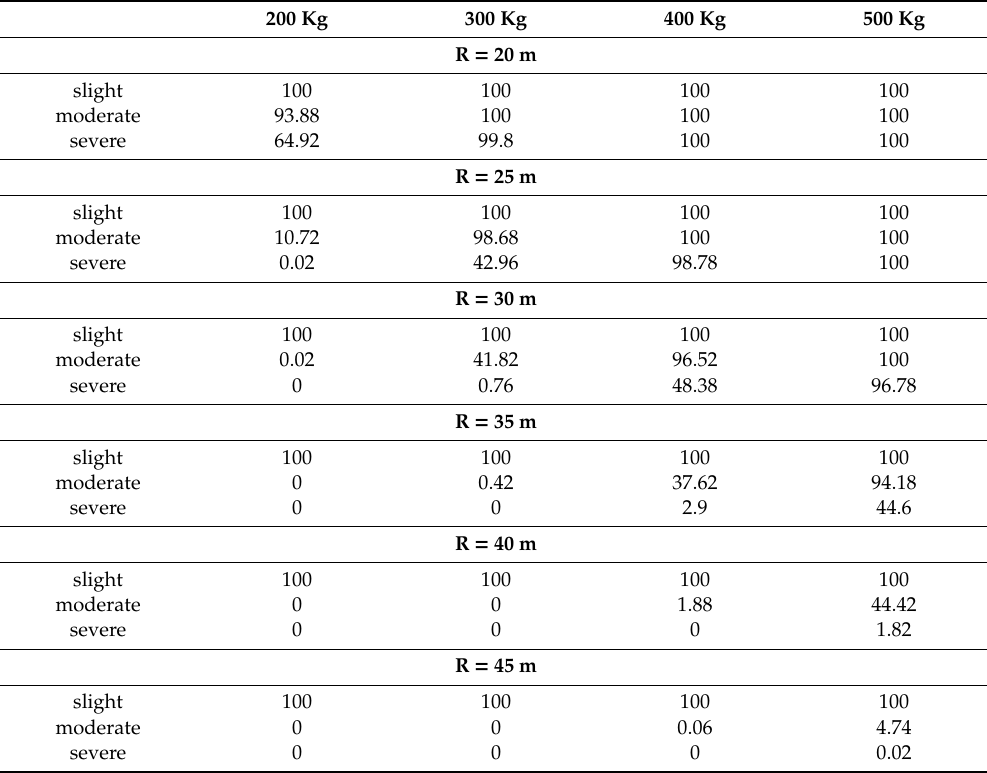
Table 7. Percentage probability of thresholds exceedance for L’Aquila location.